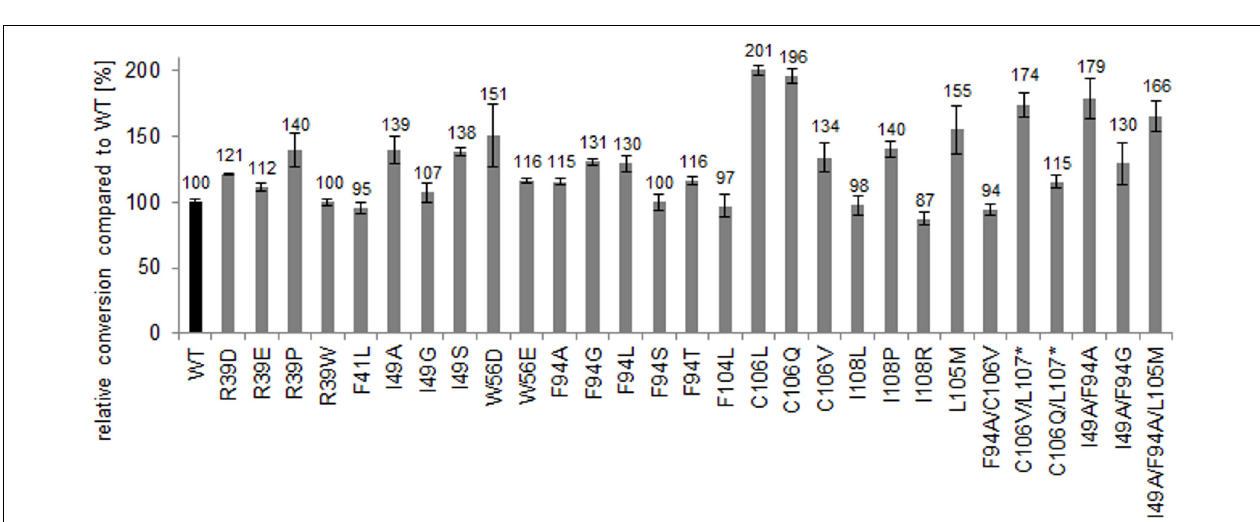
FIGURE 5 | Microtiter plate assay (re-screening) of the best hits using α -methylstyrene as substrate. The percentage increase of activity of the variants (mean value of septuplicates on one microtiter plate) refers to comparison with the wild type activity (mean value of septuplicates on the same plate, which is set to 100).